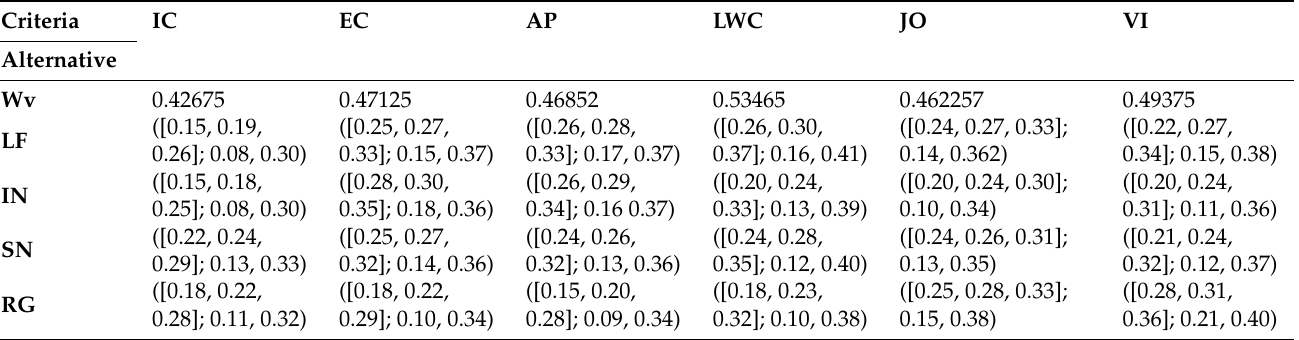
Table 5. The weight vector of the criteria and the constructed weighted normalization matrix.